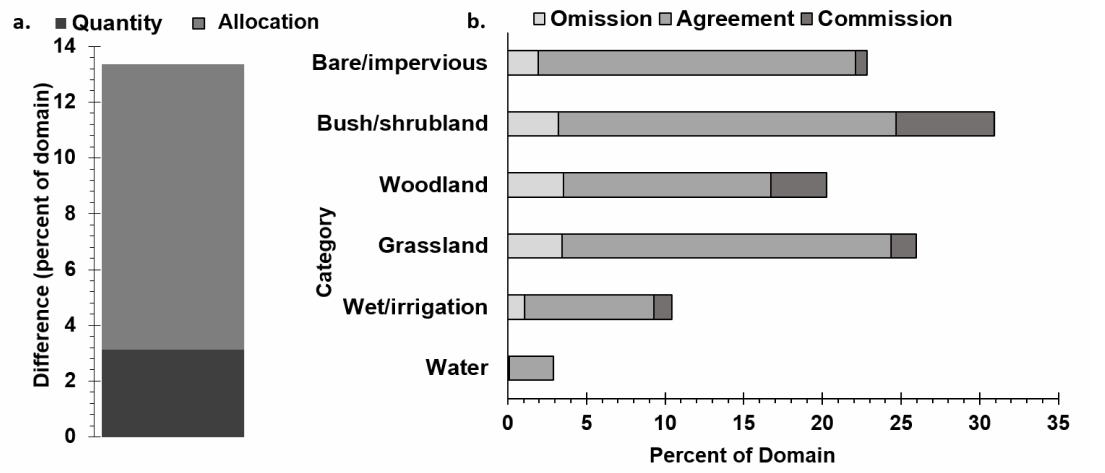
Figure 3. ( a ) Summary of overall disagreement between 2013 land cover classification and reference data, separated into the components of quantity and allocation. ( b ) Summary of agreement, omission disagreement, and commission disagreement between 2013 land cover classification and reference data by cover class as a percent of the study area